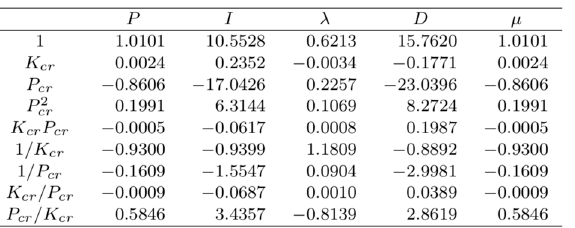
Figure 8. Parameters for the third set of tuning rules for processes with critical gain and period ( P =